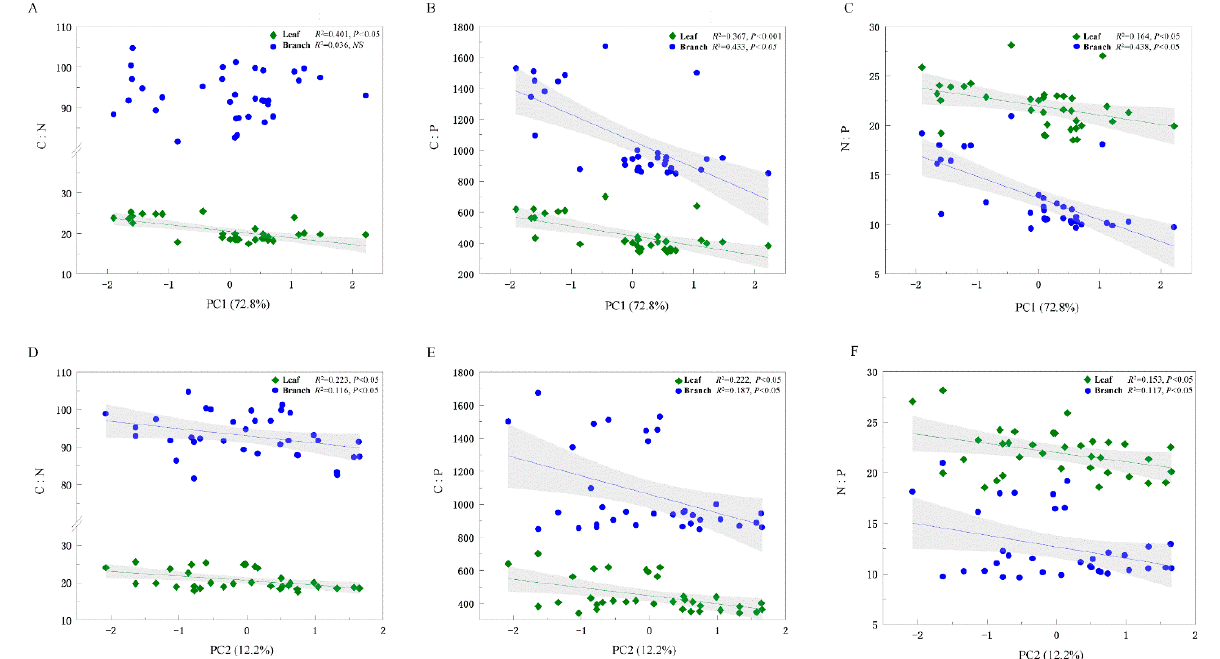
Figure 3. C, N, and P stoichiometric ratios related to soil properties’ PCA scores. C:N, ratio of carbon to nitrogen concentration ( A , D ); C:P, ratio of carbon to phosphorus concentration ( B , E ); N:P, ratio of nitrogen to phosphorus concentration ( C , F ).